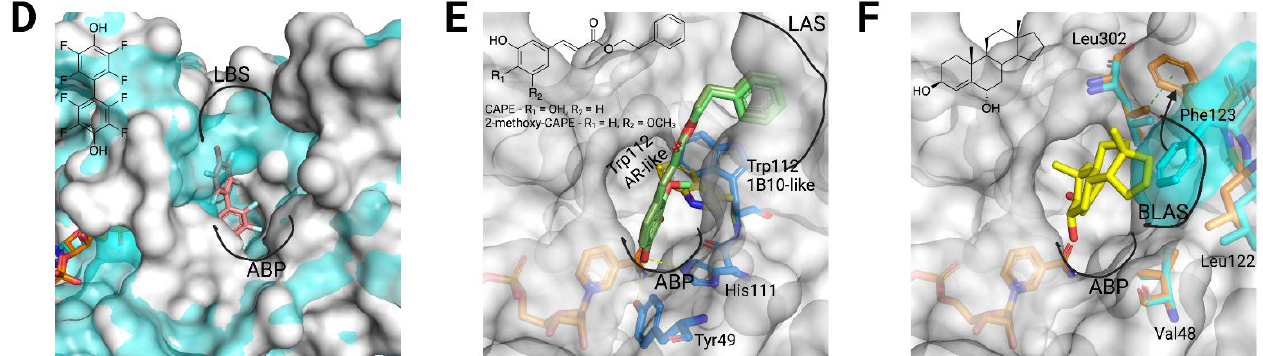
Figure 5. Structural bases for AKR1B10 selectivity (2). ( A ) Representation of the AKR1B10 (surface and blue)-NADP + (orange)-flufenamic acid (green) structure (PDB ID 4I5X), with ABP, Trp21 and Trp112 conformations indicated. The last two are compared with the equivalent in the AKR1B10 holoenzyme structure (gold, PDB ID 4GQG). Short contacts between the inhibitor and Trp112 in AR-like conformation (in the holoenzyme structure) indicated with red dashed lines. ( B ) Representation of the AKR1B10 (surface)-NADP + (orange)-JF0049 (cyan, Br atoms as spheres) structure (PDB ID 4XZL), with ABP and loop A subpocket (LAS) and its buried water molecules indicated. ( C ) Representation of the AKR1B10 (surface and blue)-NADP + (orange)-MK204 (pink) structure (PDB ID 5LIY), with ABP, SP, Trp112 conformation, Cys299 and buried water molecules in SP and LAS indicated. ( D ) Representation of the AKR1B10 (surface and blue)-NADP + (orange)-JF0064 (light pink) structure (PDB ID 4ICC), with ABP and loop B subpocket (LBS) indicated. The protein surface is compared to the equivalent in the AKR1B10 holoenzyme structure (blue surface, PDB ID 4GQG), showcasing the LBS opening induced by inhibitor binding. ( E ) Representation of the AKR1B10 (surface and blue)-NADP + (orange)-CAPE/2-methoxy-CAPE (khaki/green) structure (PDB ID 4GQ0/manually docked), with ABP, LAS, Trp112 conformation, Tyr49 and His111 indicated. Trp112 conformation is compared with the equivalent in the AKR1B10 holoenzyme structure (gold, PDB ID 4GQG). Short contacts between the 2-methoxy-CAPE and Trp112 in AR-like conformation (in the holoenzyme structure) indicated with red dashed lines. ( F ) Representation of the AKR1B10 (surface and orange)-NADP + (orange)-Androst-4-ene- 3β,6α -diol ( 3a , yellow) structure (PDB ID 5Y7N), with ABP and base of loop A subpocket (BLAS, with its lining residues) indicated. The protein surface is compared to the equivalent in the AKR1B10 holoenzyme structure (blue surface and sticks, PDB ID 4GQG), showcasing the BLAS opening induced by inhibitor binding and involving a conformational change of Phe123. The last is stabilized in the current structure by a stacking contact with Leu302, indicated by a green dashed line. 2D molecular structures of inhibitors are also depicted. Created with PyMoL 2.3.0. and in biorender.com.